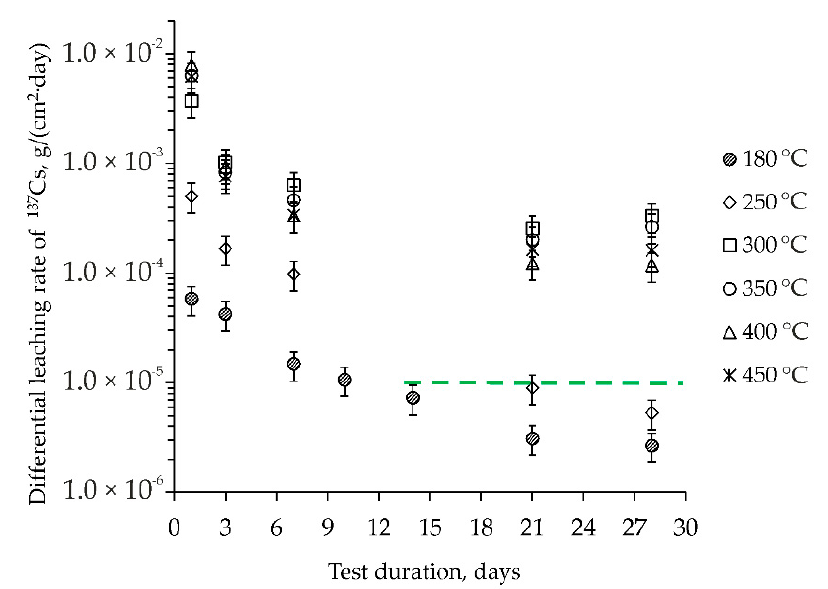
Figure 3. Kinetic curves of the 137 Cs leaching rate from MPP-FKN-W compound samples in dependence on the temperature of their heat treatment ( green line is the upper limit of the 137 Cs leaching rate requirements for vitrified HLW [1] ).